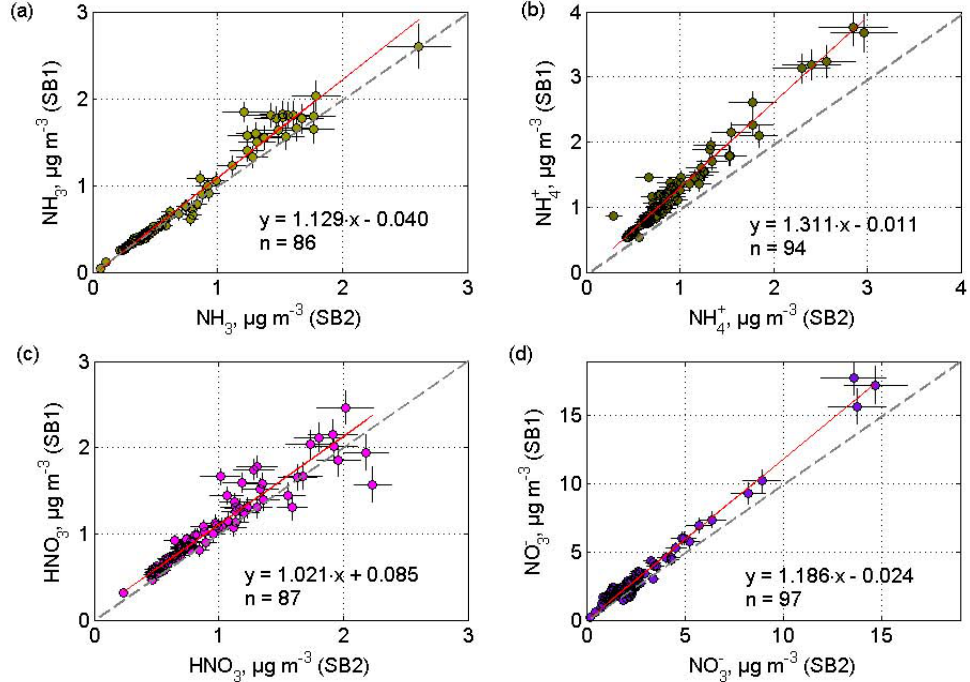
Fig. 8. Results from side-by-side measurements during the EGER experiment. The error bars indicate the random errors of the concentration measurements. Red lines and the equations represent the individual orthogonal fits. n is the number of data points used for each fit. The dashed line indicates the 1:1 line. (SB1: sample box 1; height 24.4m; SB2: sample box 2; height